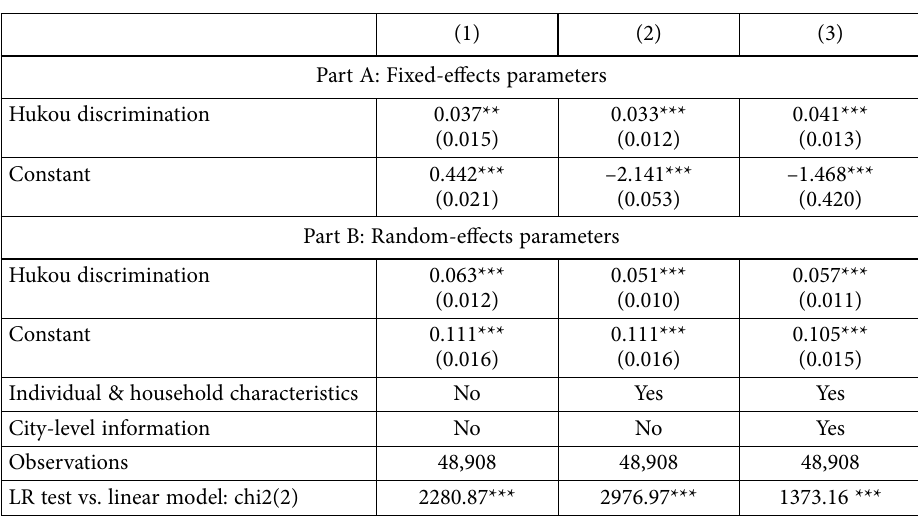
Table 5. Hukou discrimination and entrepreneurship: mixed-effects model (sample of rural